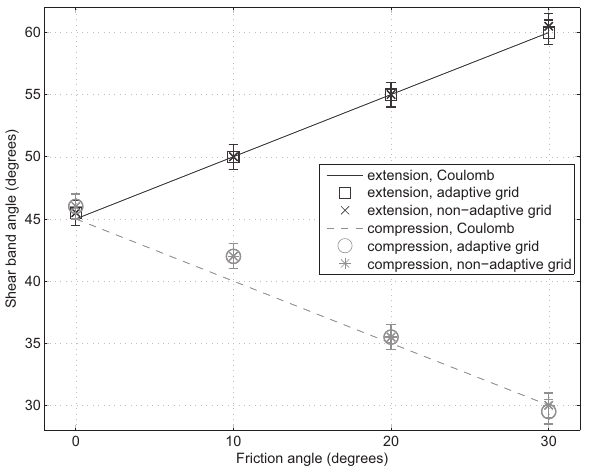
Figure 23. Orientations of shear bands in extension/compression simulations with different fric- tions